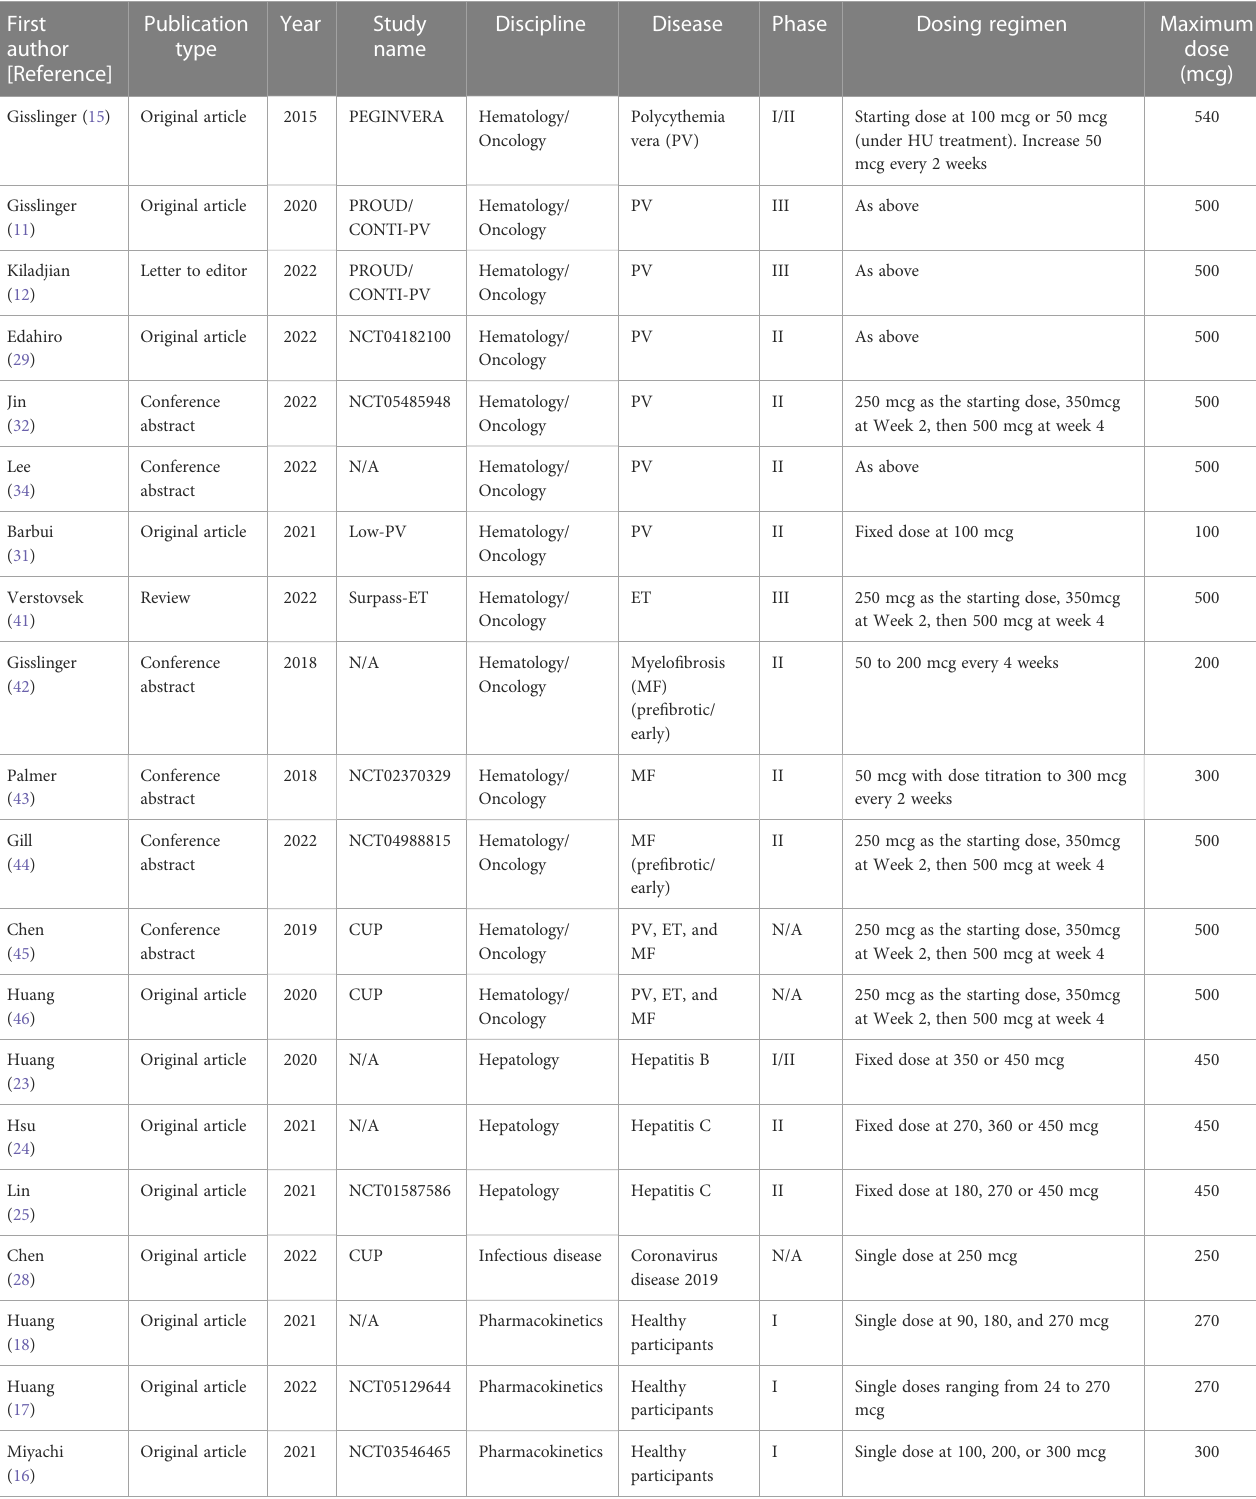
TABLE 2 Overview of clinical studies with ropeginterferon